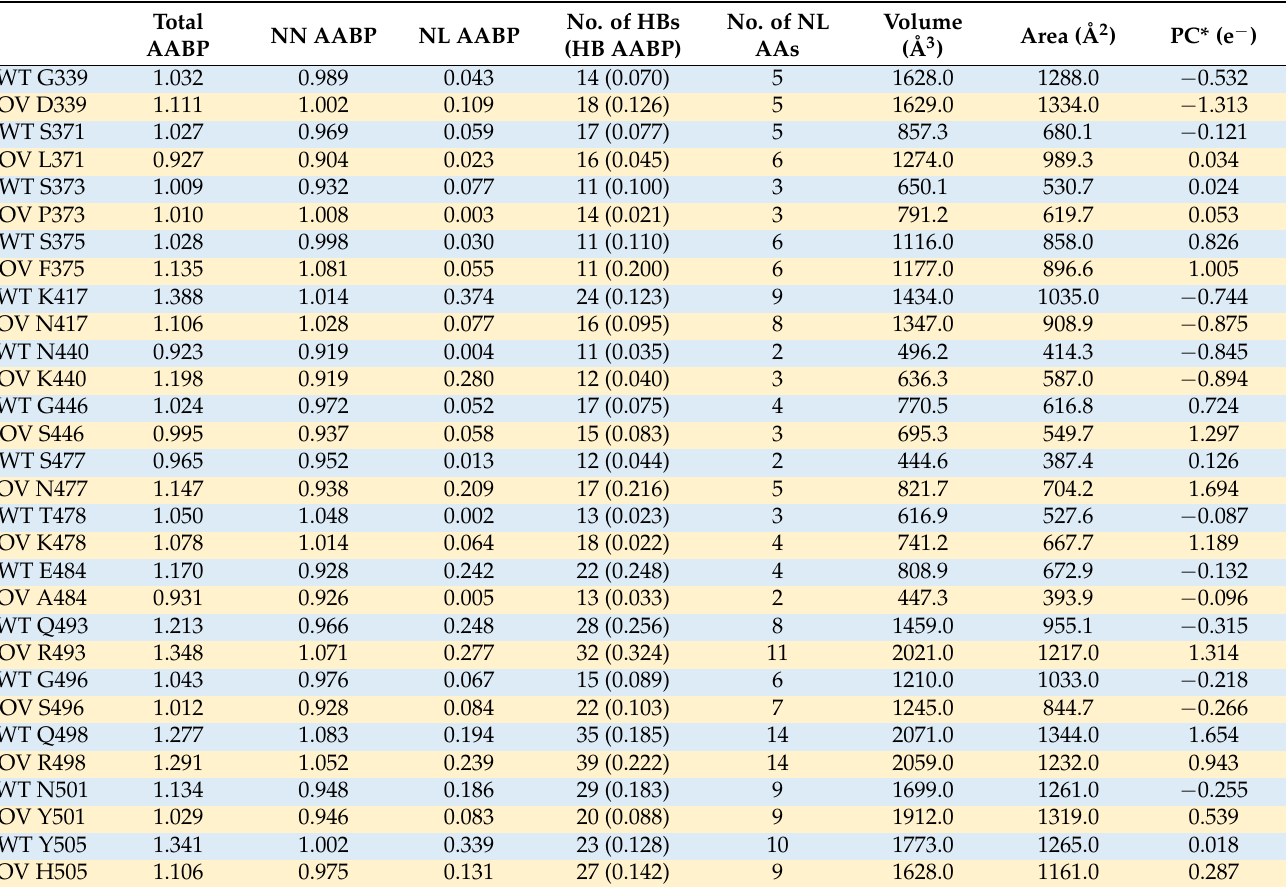
Table 2. Comparison of AABP units for the 15 OV mutations in RBD-ACE2 complex with their corresponding WT sites. AABP is in the unit of electrons (e −